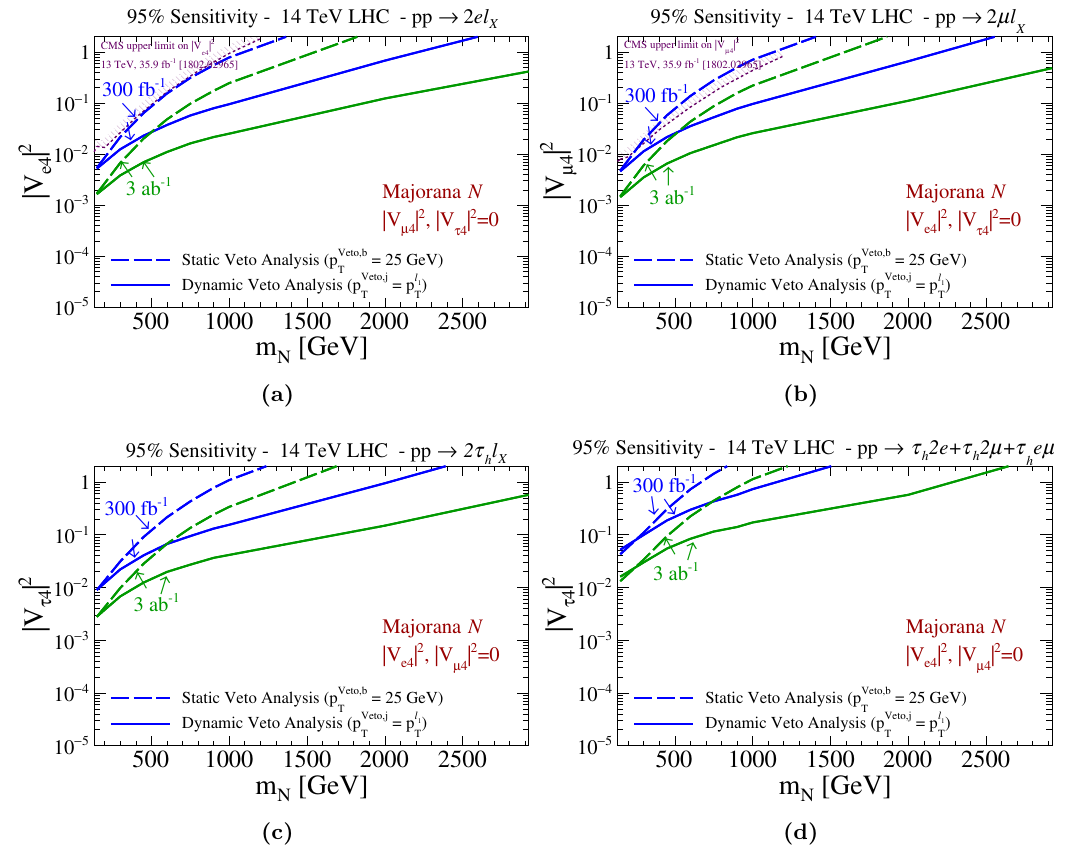
Figure 24. Same as (cid:12)gure 22 but for a single Majorana N in a phenomenological Type I